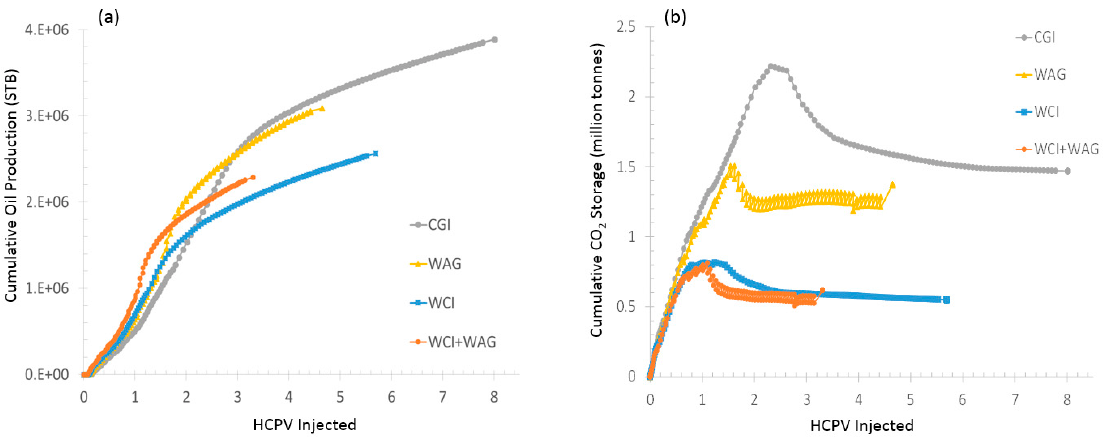
Figure 4. ( a ) Cumulative oil production as a function of CO 2 volume injected. ( b ) CO 2 storage as a function of CO 2 volume injected. HCPV = hydrocarbon pore volume.